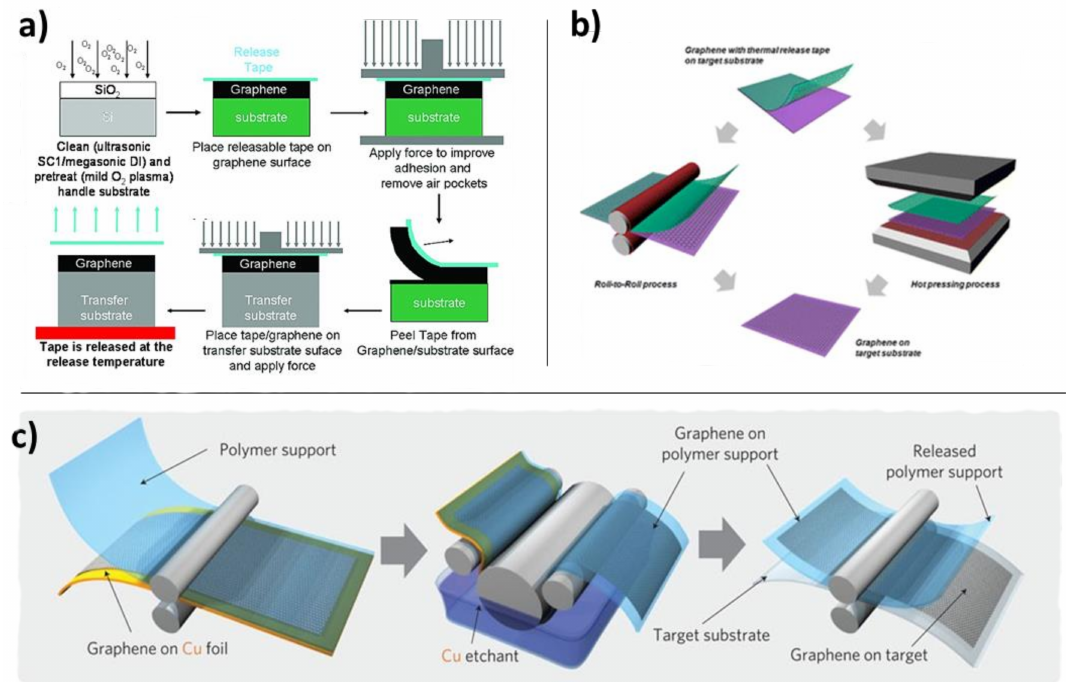
Figure 10. Thermal release tape strategies for temporarily weakening the graphene-substrate interaction to effect transfer to the target substrate. ( a ) Cold pressing with thermal release tape to remove air pockets. Reprinted with permission from Ref. [109]. Copyright 2010 American Chemical Society. ( b ) Roll-to-roll hot pressing with thermal release tape for large-area graphene transfer. Adapted with permission from Ref. [110]. Copyright 2012 American Chemical Society. ( c ) Large-area roll-to-roll graphene transfer with etching of original substrate and use of thermal release tape. Reprinted with permission from Ref. [112]. Copyright 2010 Springer